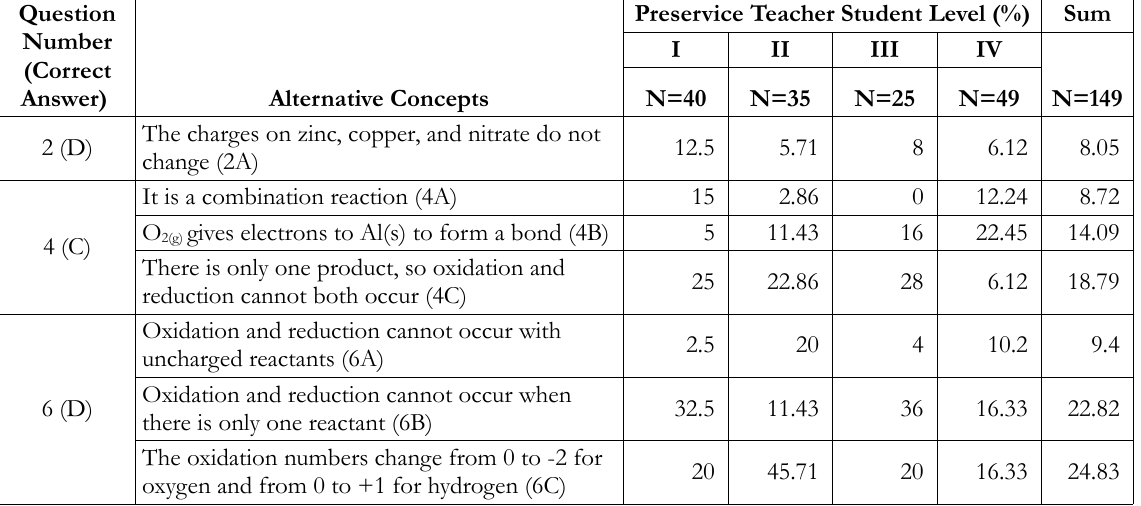
Table 7. Percentage of Alternative Concepts of Preservice Chemistry Teachers on Redox Concepts in Two-tiered Answer/Reason Paired